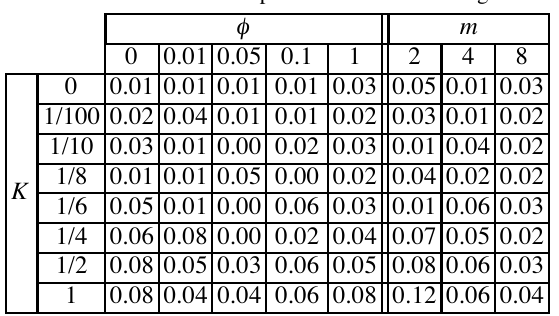
Table 8. Influence of the update method in the SH